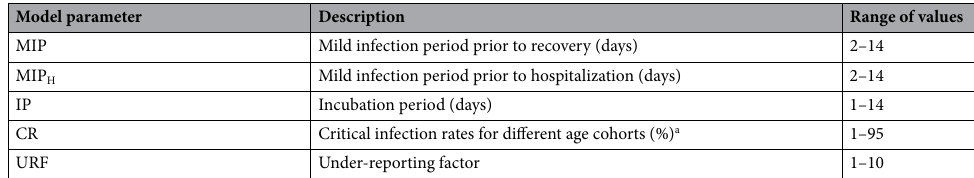
Table 1. Parameters used in model calibration and their plausible range of values. a Constraints were defined for critical infection rates for different age cohorts as: CR 0-17 < CR 18-44 < CR 45-64 < CR 65-74 < CR 75 +